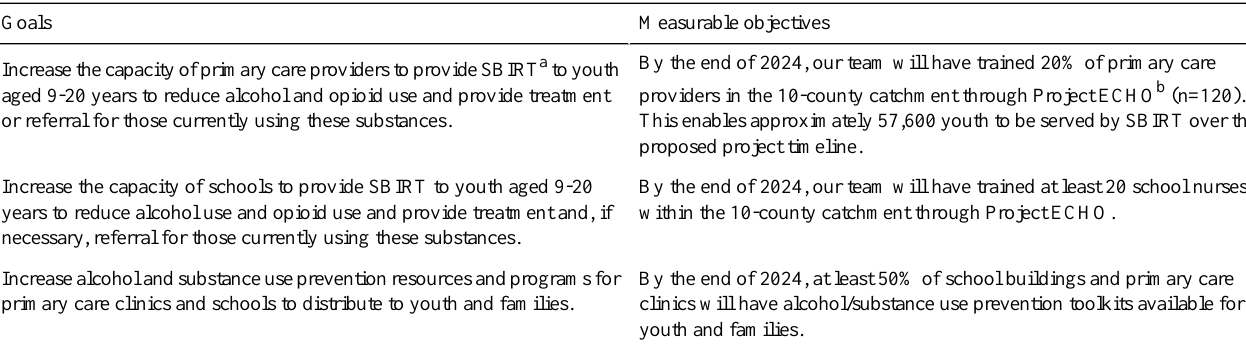
Table 2. Proposed goals and measurable